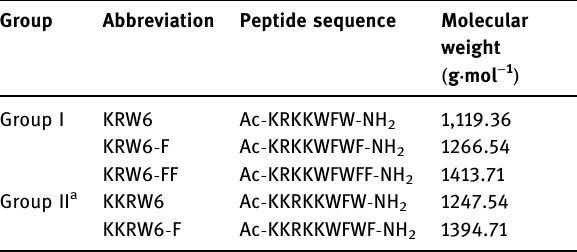
Table 1: Peptide sequence and molecular weight of each designed peptide Group Abbreviation Peptide sequence